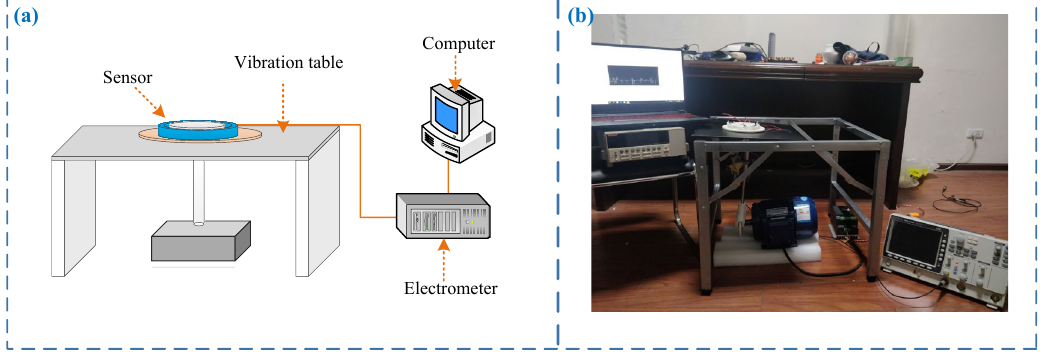
Figure 3. Test devices. ( a ) The schematic of the test devices; ( b ) a picture of the test devices.